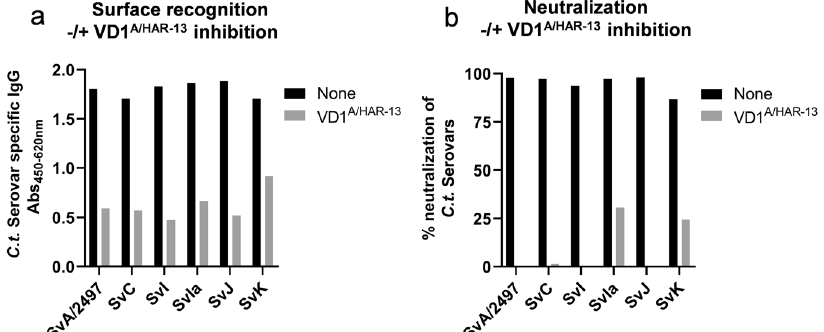
Fig. 6 Competitive inhibition of surface recognition and neutralization. A/J mice were immunized with extVD1 A *4/CAF01 ( n = 20) or CAF01 alone ( n = 20) using the SIM vaccination protocol. ExtVD1 A* 4-speci fi c serum was pooled from 20 mice, prediluted, and mixed with 1 mg/ml of VD1 A/HAR-13 or 1× PBS buffer. After incubation, the mixture was added to C.t .-coated ELISA plates in duplicates and C.t .-speci fi c IgG measured by ELISA ( a ). Each bar represents the mean of duplicate readings with and without the presence of the VD1 A/HAR-13 peptide. ExtVD1 A* 4-speci fi c serum was pooled from 20 mice, prediluted, and mixed with 1 mg/ml of VD1 A/HAR-13 or SPG buffer. After 45 min of incubation, the mixture was further incubated 1:1 with different C.t . serovars for 45 min before inoculation onto a HaK cell monolayer, incubated, fi xed, and inclusions counted ( b ). Bar represents % neutralization with and without the presence of the VD1 A/HAR-13